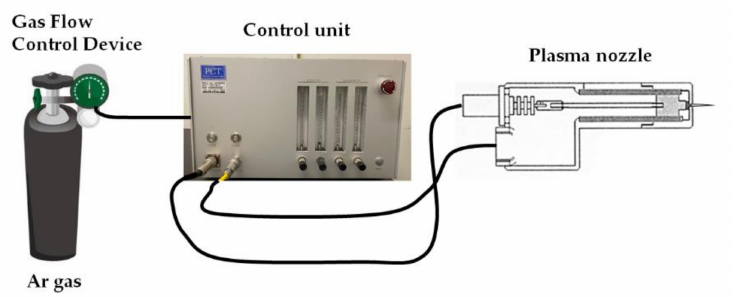
Figure 1. Argon-based non-thermal atmospheric pressure plasma (NTAPP) stimulation device used in this study. The multi-gas plasma jet source has a columnar body like a pen connected to an AC power supply of 16 kHz and 9 kV and a gas